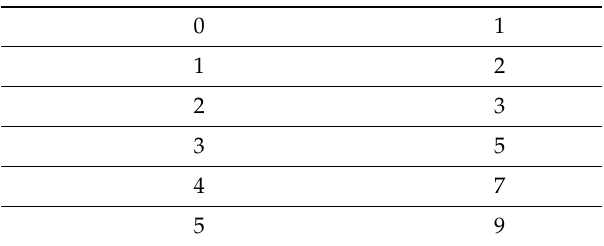
Table 11. Pairwise comparison rankings for difference in ranking of parameters based on saaty scale (9 to 1/9). Difference in Ranking of Parameter Satty Scale